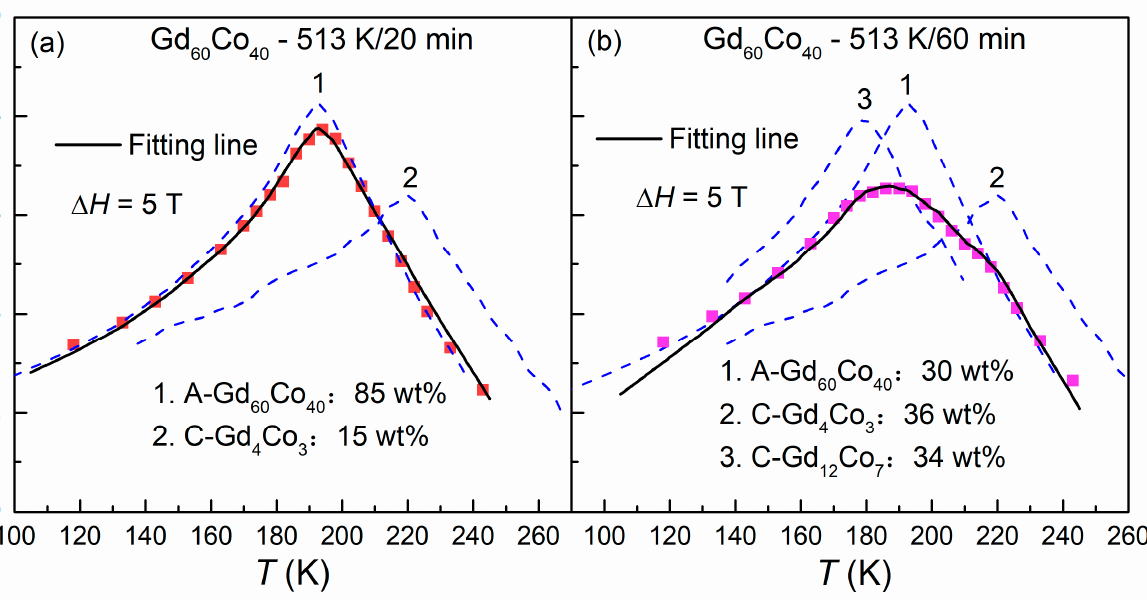
Figure 7. Temperature dependence of | ∆ S M | for the annealed Gd 60 Co 40 alloys: ( a ) 513 K/20 min and ( b ) 513 K/60 min, fitted by calculating experimental data of constituent materials 1, 2 and 3, which correspond to amorphous Gd 60 Co 40 [17], crystalline Gd 4 Co 3 [21] and melt-spun Gd 12 Co 7 [22], respectively.